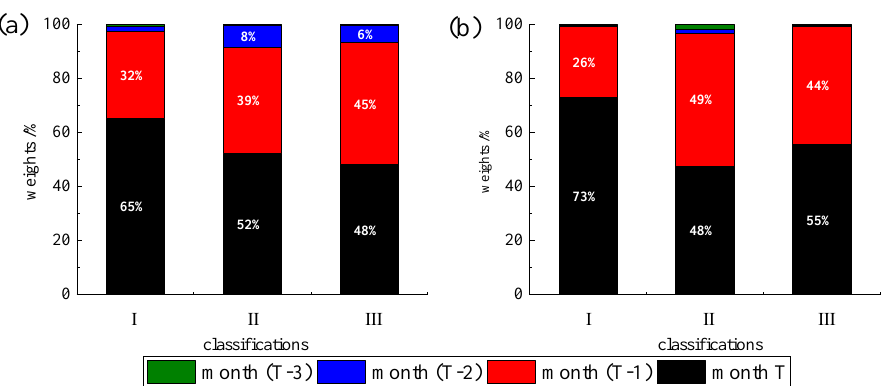
Figure 12. Average values of the lag patterns detected by method 4. ( a ) Precipitation; ( b ) tempera- ture; Ⅰ —Mixed Forest; Ⅱ —Grassland; Ⅲ —Barren or Sparse Vegetation.